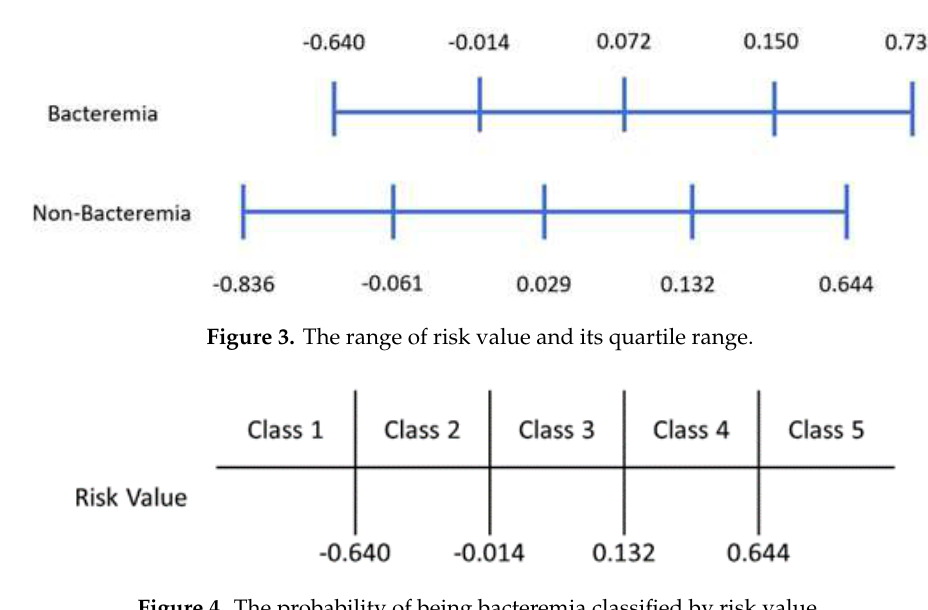
Table 6. Distribution of several variables in febrile children under the age of 3 years old with or without bacteremia.